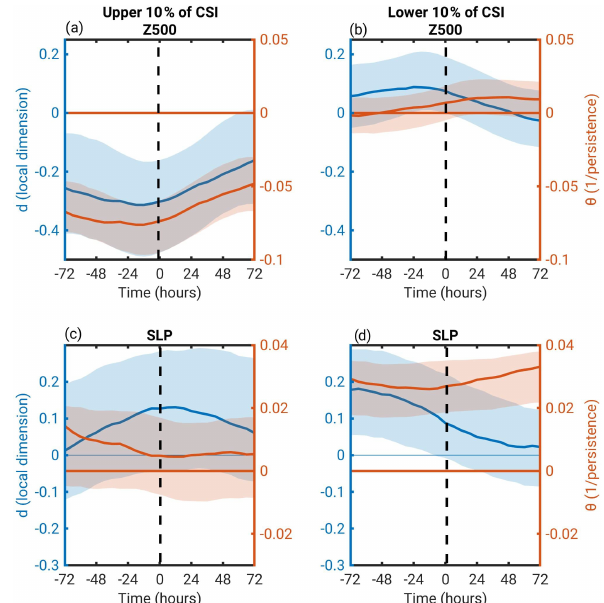
Figure 4. The average temporal evolution of the dynamical sys- tems metrics ( d and θ ) for heat wave (upper 10% of CSI) and cool day (lower 10% of CSI) events. The dynamical systems met- rics were computed for (a, b) Z 500 and (c, d) SLP. The events are centered (0h) on the first day of CSI ≥ 90% or CSI ≤ 10% and at 12:00UTC. A 95% bootstrap confidence interval is plotted (shad-